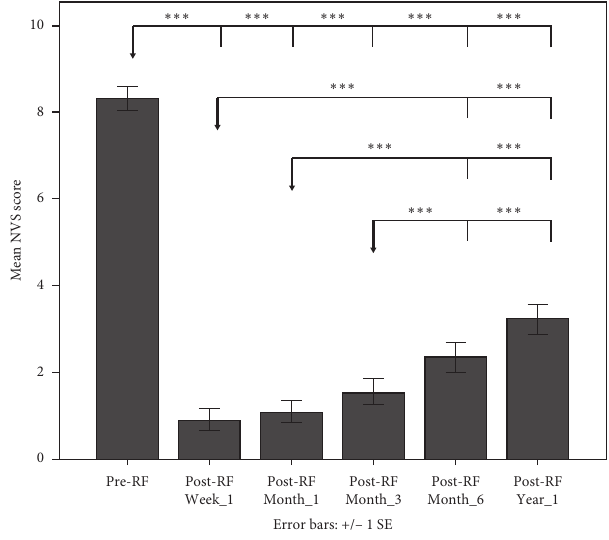
Figure 2: Bar chart illustrating mean NVS scores and standard error (1SE) prior and during the follow-up period across all groups (note: the reference point for each comparison is indicated with a grey arrow; ∗∗∗ p < 0 . 005, ∗∗ p < 0 . 01, and ∗ p < 0 . 05 after Bonferroni